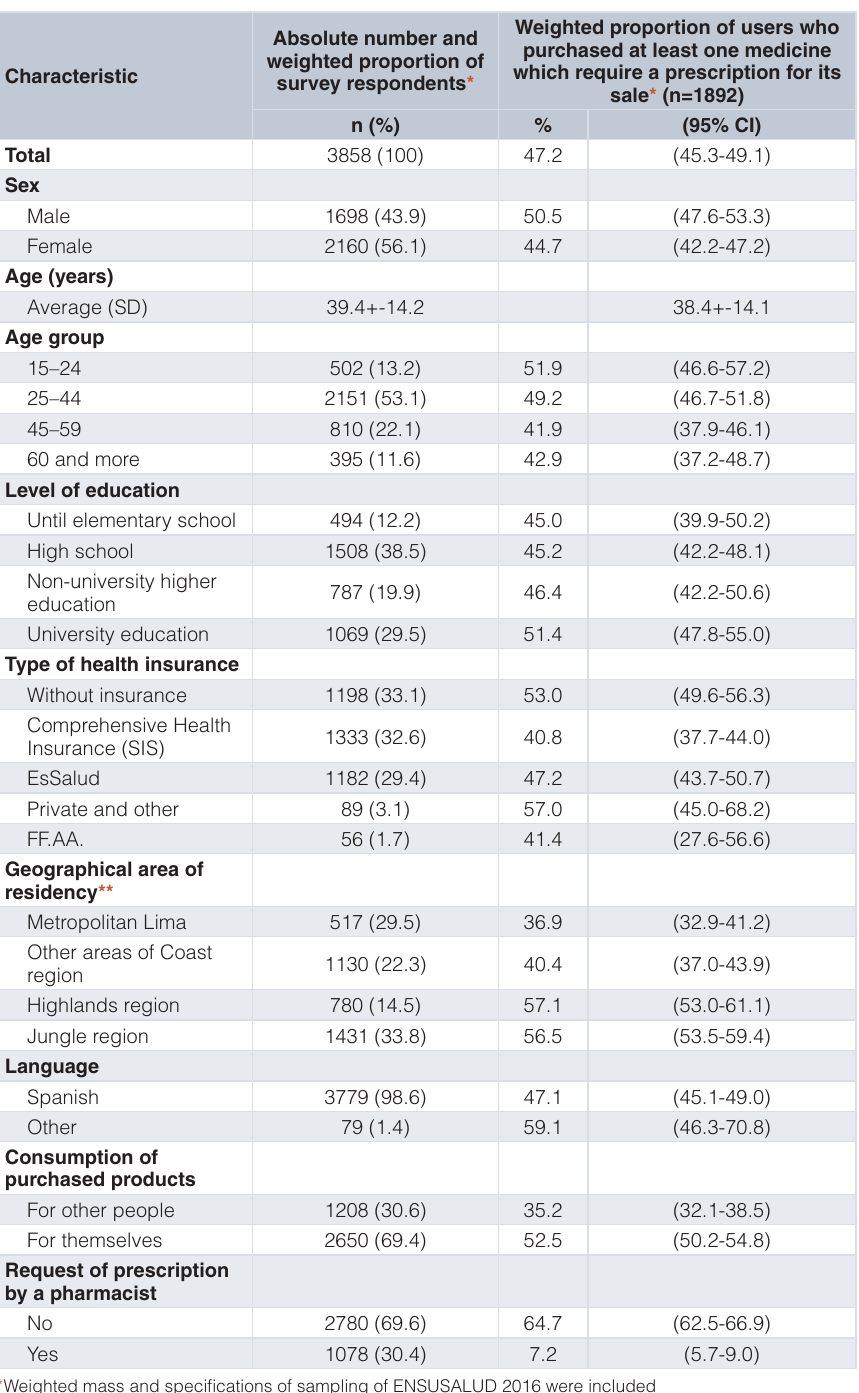
Table 1. General characteristics of the population included in the study and the proportion of users who purchased prescription medicines without medical prescription in Peru, Encuesta Nacional de Satisfacción de Usuarios en Salud (ENSUSALUD) 2016